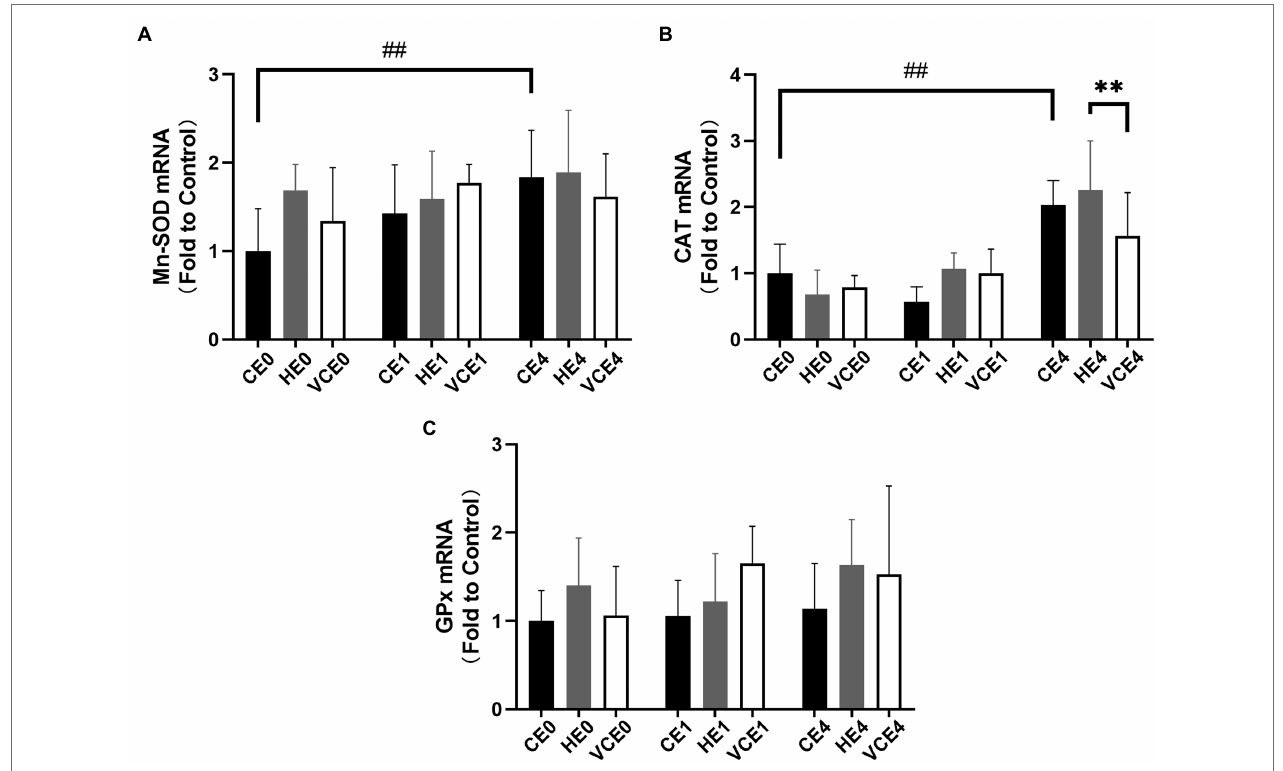
FIGURE 6 | The mRNA expression levels of superoxide dismutase Mn-SOD (A) , CAT (B) , and glutathione peroxidase (GPx) (C) in gastrocnemius muscle detected by RT-qPCR. C, blank control; H, inhalation of hydrogen gas; VC, vitamin C supplementation; E0, baseline; E1, immediately after exercise; and E4, 4 h after exercise. n = 8 per group. ** p < 0.01; ## p < 0.01.